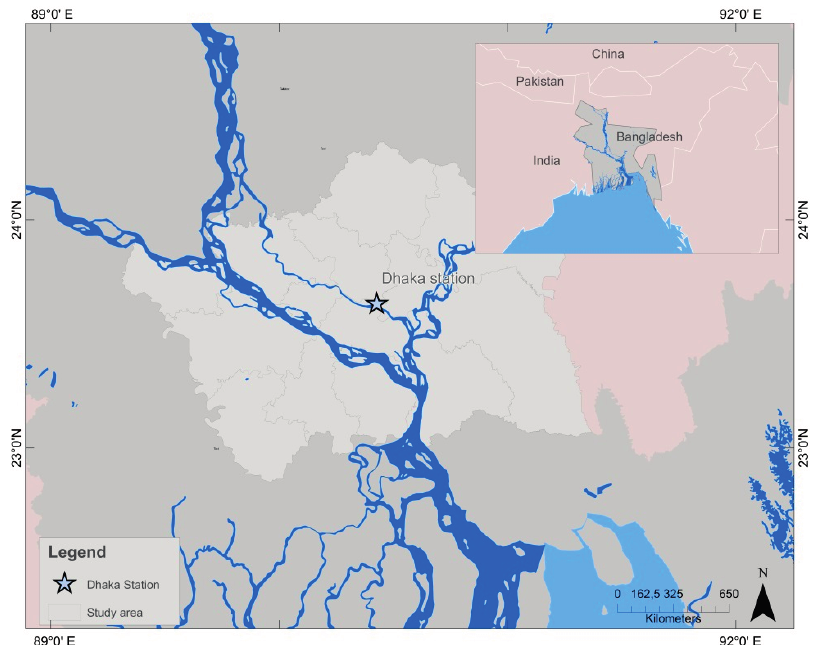
Figure 1. Map of study area, showing the river systems immediately surrounding Dhaka City as well as the location of the water level